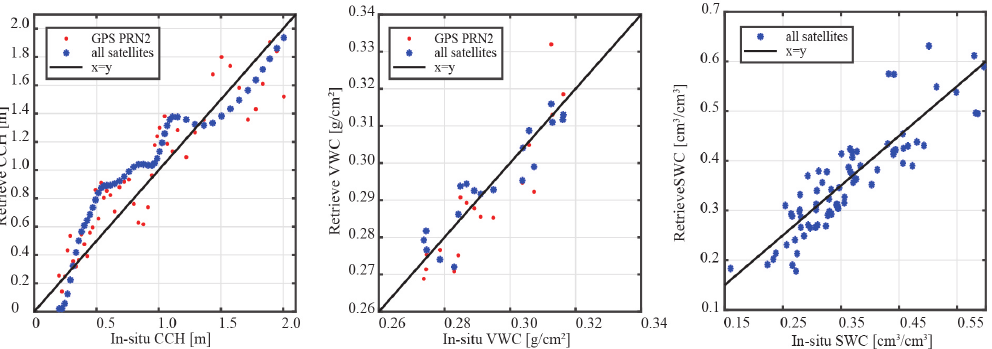
Figure 13. Scatter of retrieved results and in situ